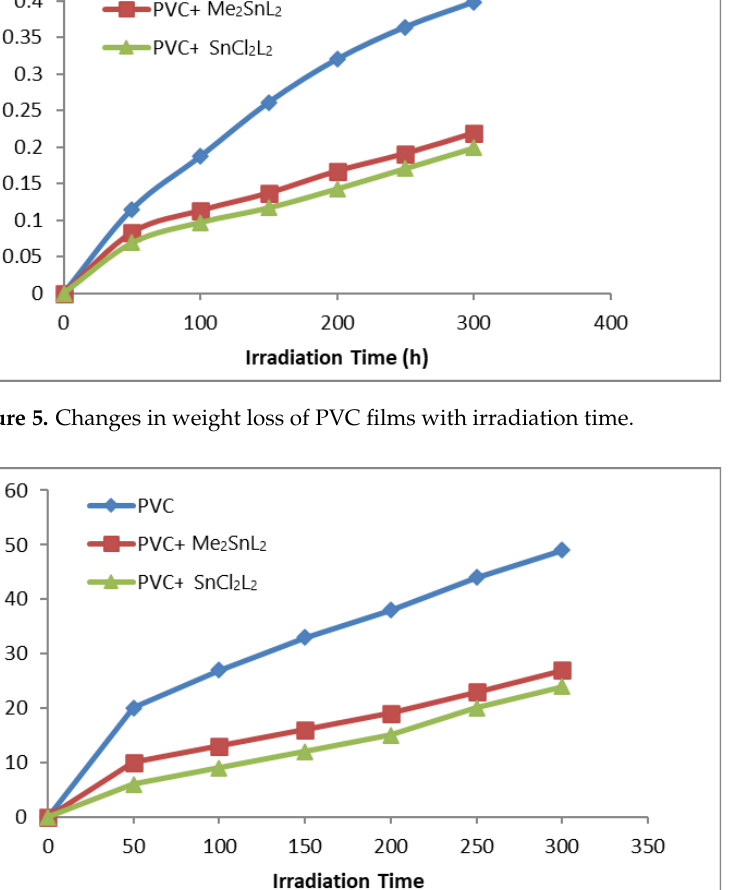
Figure 7. Changes in 𝑀(cid:3365) (cid:3023) for PVC films versus irradiation time. At the end of the irradiation process, the 𝑀(cid:3365) (cid:3023) for PVC/SnL 2 Cl 2 and PVC/Me 2 SnL 2 blends was 102,416 and 93,292, respectively. Again, the tin complexes, and particularly SnL 2 Cl 2 , stabilized the PVC against irradiation to a remarkable degree.